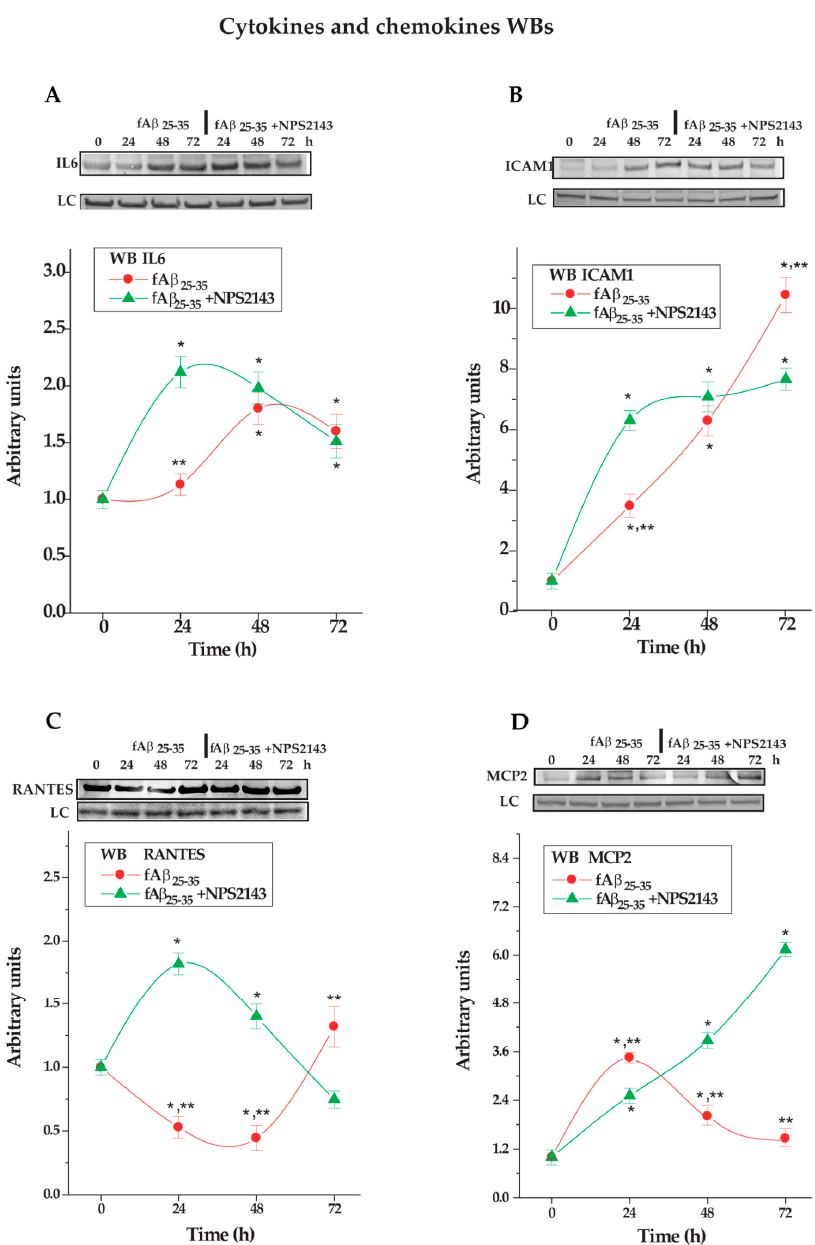
Figure 4. Changes in protein lysates’ levels of ( A ) IL-6, ( B ) s-ICAM-1, ( C ) RANTES, and ( D ) MCP-2 in NAHAs treated with fA β 25–35 ± NPS 2143 vs. untreated controls (CTR). At the top of each panel are typical immunoblots showing the densitometric changes of each agent according to treatments vs. untreated controls (CTR). LC, loading control. The graphs underneath show the densitometric evaluations of the specific bands at each time point of every treatment. Points on the curves are mean values of three independent experiments, each carried out in duplicate with control (0-h) values normalized as 1.0. One-way ANOVA followed by post hoc Tukey’s test allowed to calculate p values. * p < 0.05 vs. CTR; ** p < 0.05 vs. fA β 25–35 + NPS 2143.